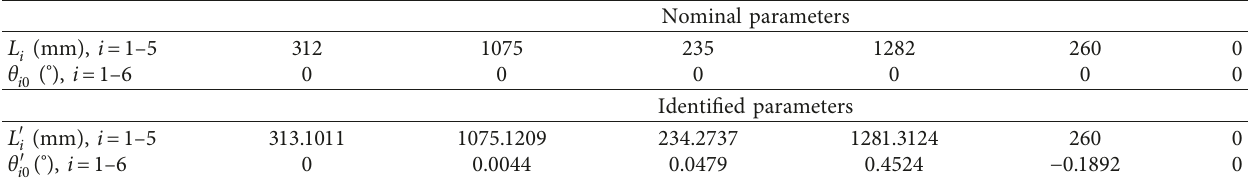
Figure 4: Experimental scene. Table 3: Nominal value and identified value of robot geometric parameters.